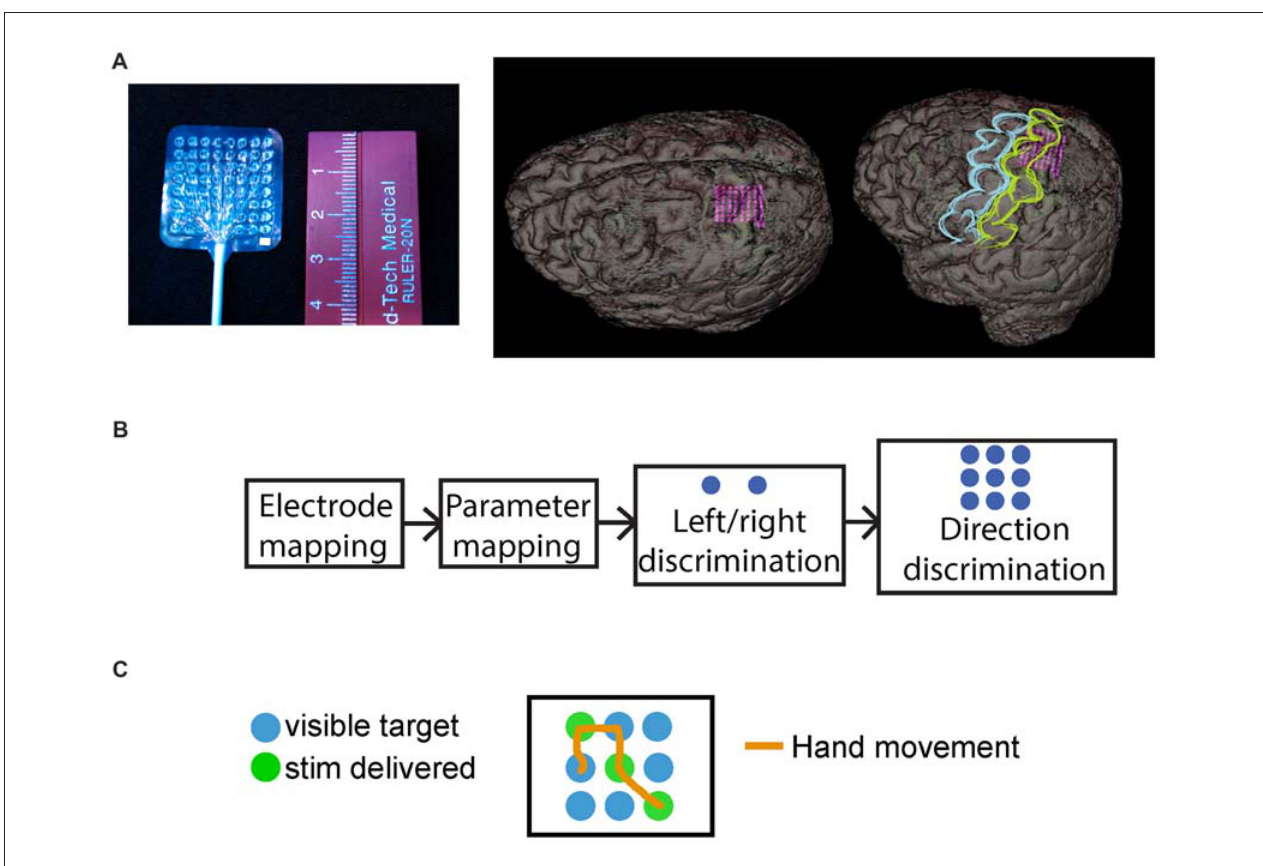
FIGURE 2 | Mini-electrocorticography (mini-ECoG) grid and experimental paradigm. (A) On the left, the Ad-Tech “mini” electrocorticography grid used, with 64 2-mm platinum contacts, spaced 3 mm center-to-center. On the right, reconstructed images of the grid placement for S05, with an oblique and an overlaid representation of where primary motor cortex (blue) and primary somatosensory cortex (yellow) are in relation to the mini-grid. (B) Schematic of typical session timeline, from initial electrode mapping to behavioral tasks. (C) Exemplar trial for the “directional” behavioral task with 3-by-3 grid, where the green circles illustrate the underlying direction followed by the epileptologist to trigger stimulation, these were not visible to the subjects. The orange line shows a mock hand trajectory of subjects hand over the grid which started at one of the non-stimulated (blue), locations.